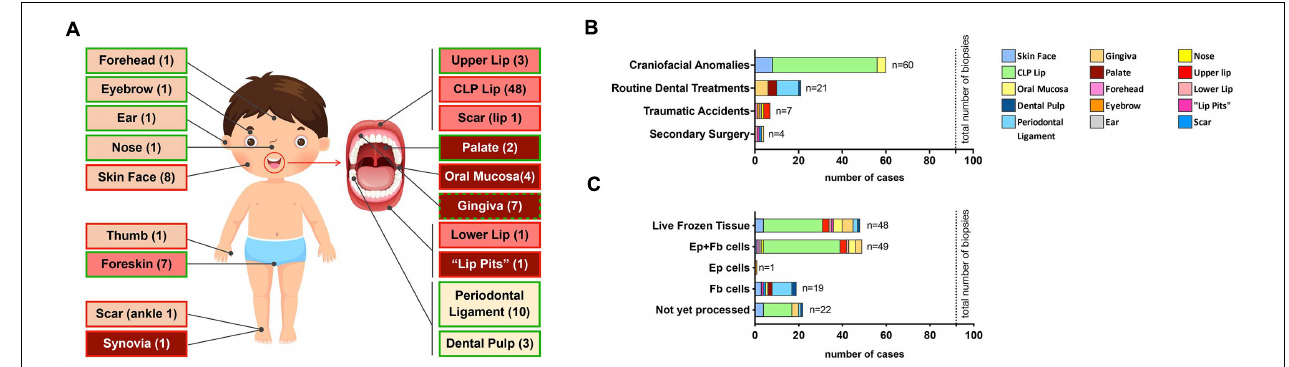
FIGURE 4 | Overall description of our living cranio-/orofacial cell repository. (A) Graphical illustration indicating the anatomical origin of stored tissue biopsies (including non-cranio-/orofacial-derived specimens). Light pink indicates skin-derived specimens; pink indicates mucocutaneous junction area-derived specimens; red indicates mucosal-derived specimens; while light yellow indicates tooth-derived specimens. Furthermore, a green border depicts healthy tissue while a red border represents tissue with anomalies. For the gingiva, we have both healthy and diseased tissues (green and red border). The number in the boxes in brackets represents the amount of tissues available. (B) Bar chart reporting the source of the specimens that were obtained for the generation of the living cell biobank. Total number of cranio-/orofacial region biopsies: 92 biopsies. (C) Bar chart of the outcome after tissue biopsy processing. The color code is shown in the legend. Total number of biopsies: